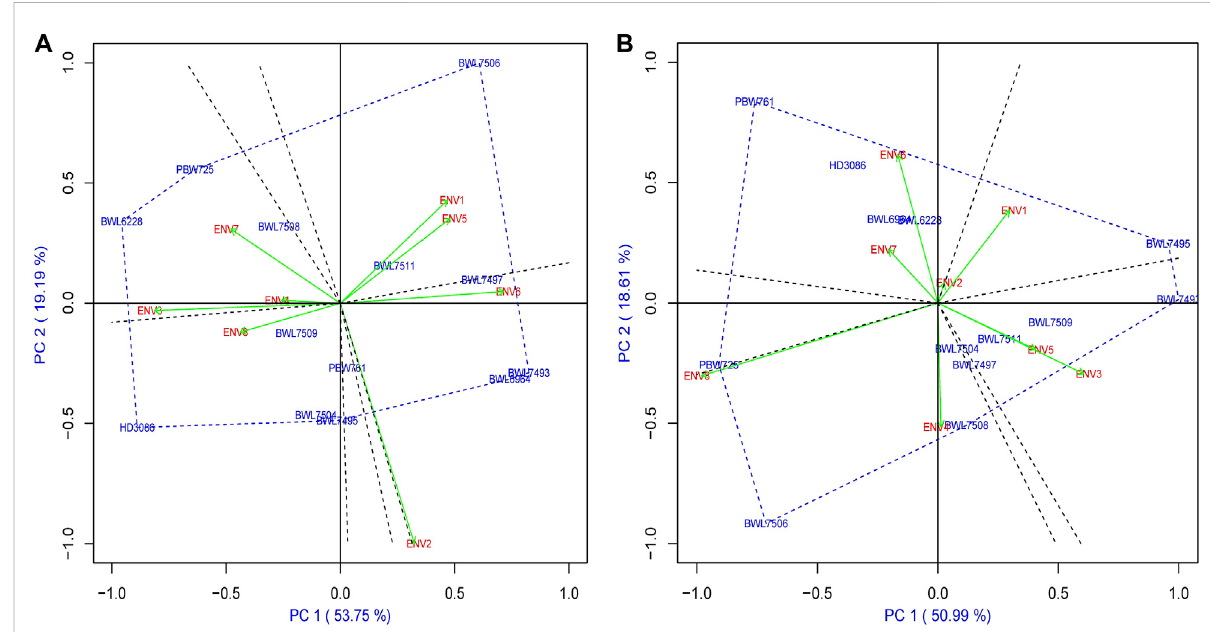
FIGURE 3 The “ AMMI2 ” graphs displays both the axes of interaction (IPCA1 and IPCA2) values for genotype effect and genotype by environment interaction effect of 13 bread wheat genotypes across four locations (Ludhiana, Ballowal, Patiala, and Bathinda) of Punjab in two consecutive years (2019 – 20 and 2020 – 21) for (A) yield (kg/plot) and (B) GPC (%). (ENV1, and ENV5 = Ludhiana; ENV2, and ENV6 = Ballowal; ENV3, and ENV7 = Patiala; ENV4, and ENV8 =